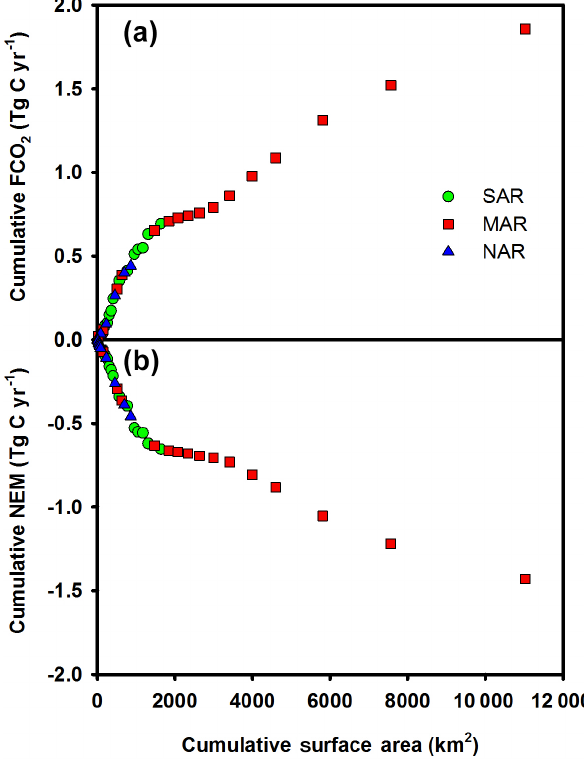
Figure 9. The cumulative FCO 2 (a) and NEM (b) as functions of the cumulative estuarine surface area. Systems are sorted by in- creasing surface